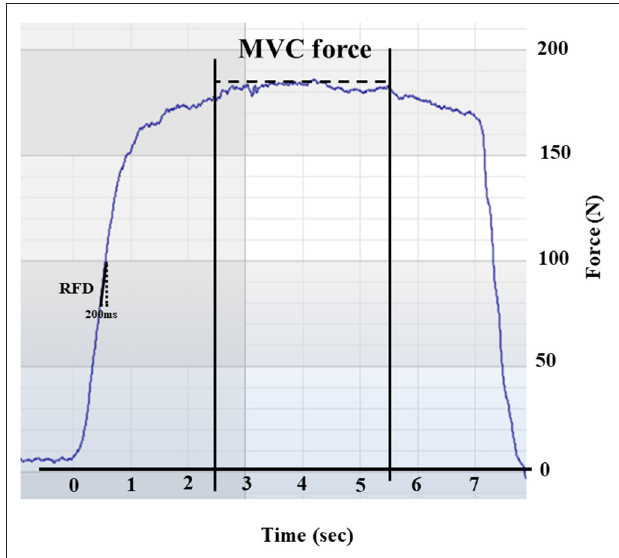
FIGURE 1 | Representative force-time curve obtained during a maximal isometric voluntary contraction (MVC) in a single subject. The figure illustrates the rate of force development (RFD) calculated over a 200-ms window and the MVC calculated over a 300-s